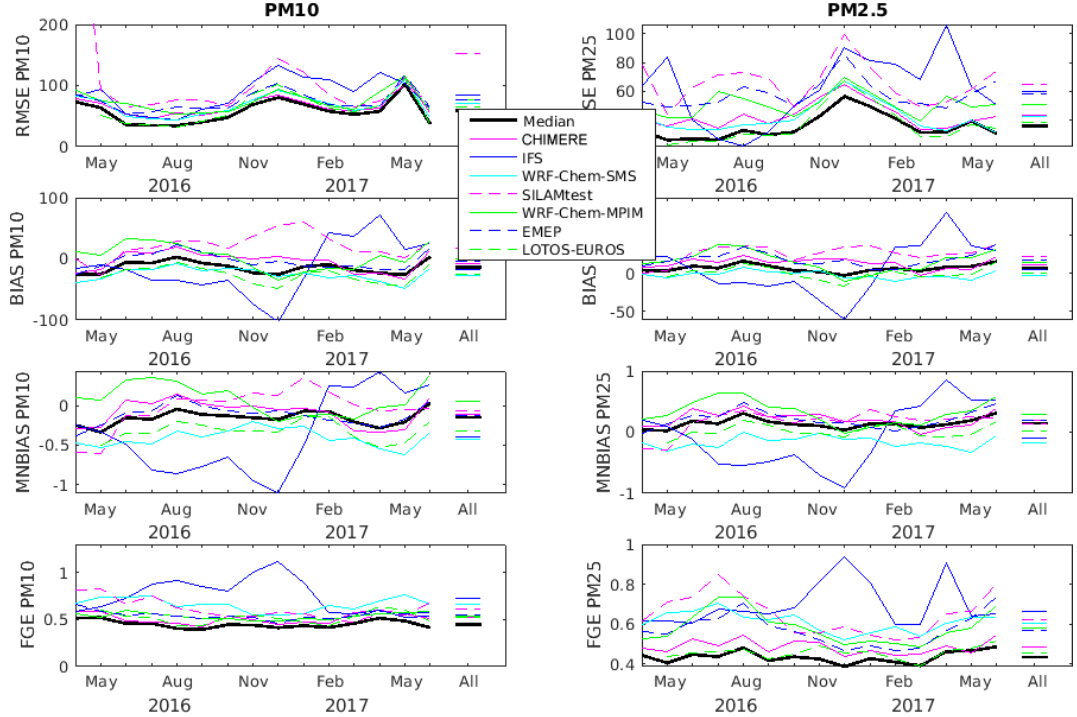
Figure 3. RMSE (in µgm − 3 ), BIAS (in µgm − 3 ), MNBIAS, and FGE of PM 10 and PM 2 . 5 for each month and for the entire time period (April 2016–June 2017 and lines on the right side of each